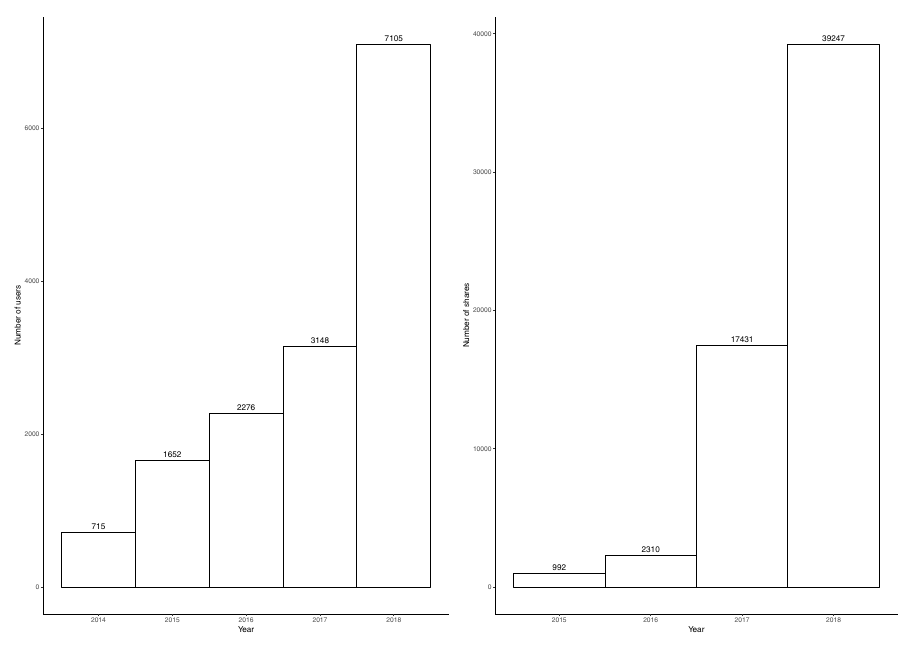
Figure 2. Number of new users every year Figure 3. Number of new shares every